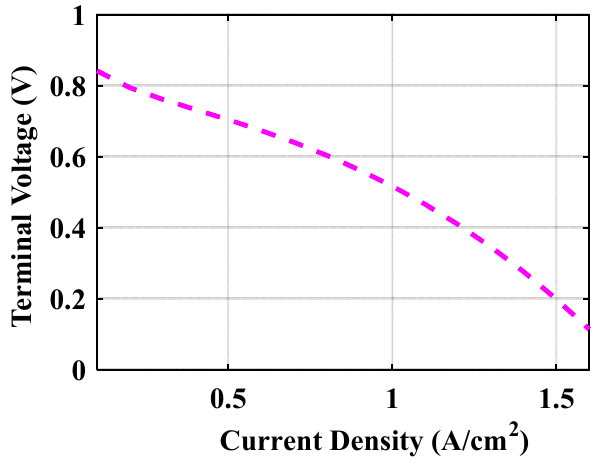
Current Density (A/cm 2 ) Figure 3. FC terminal voltage as a function of current Figure 3. FC terminal voltage as a function of current density.